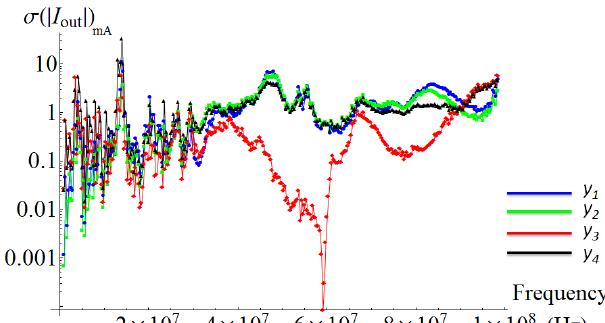
Figure 7: Computation of the end-current magnitude standard deviation for the four configurations of the MC simulations